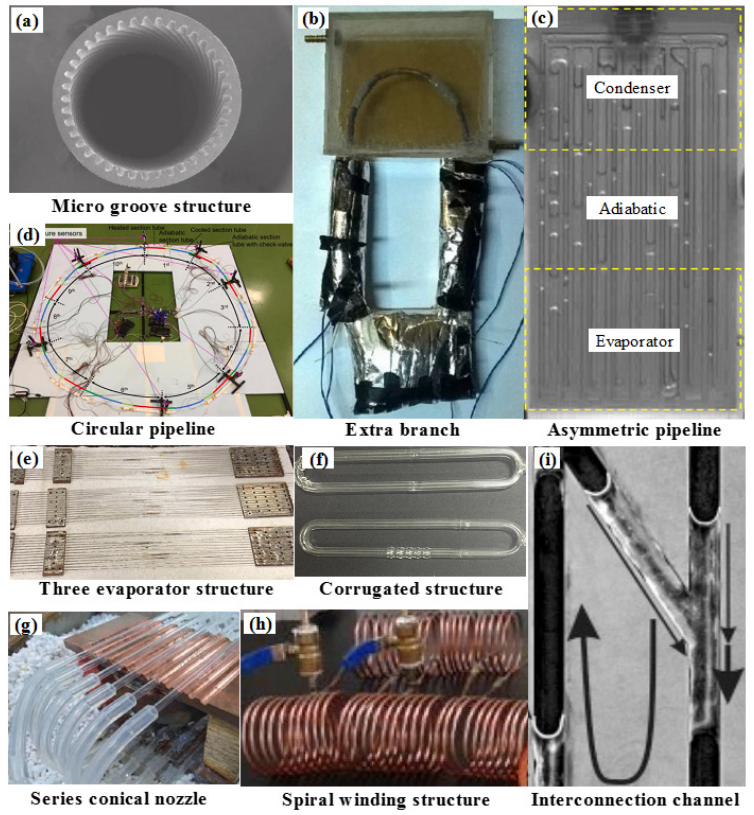
Figure 11. Partial pipeline structure: ( a ) Micro groove structure [114]. Qu et al. (2021); ( b ) Extra